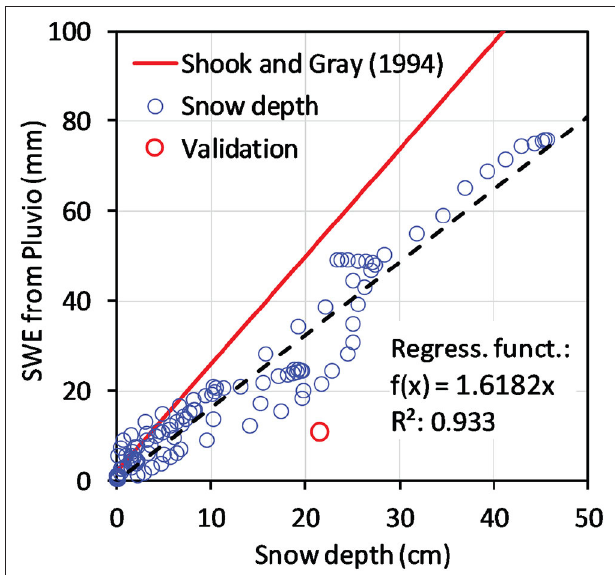
FIGURE 5 | SWE regression function derived from snow water equivalent (SWE) measured by the heated precipitation gauge (Pluvio), i.e., the accumulated precipitation readings, and the snow depth measured by the ultrasonic snow depth sensor. Results from the SWE validation campaign are also presented. In addition, the linear regression function proposed by Shook and Gray (1994) is